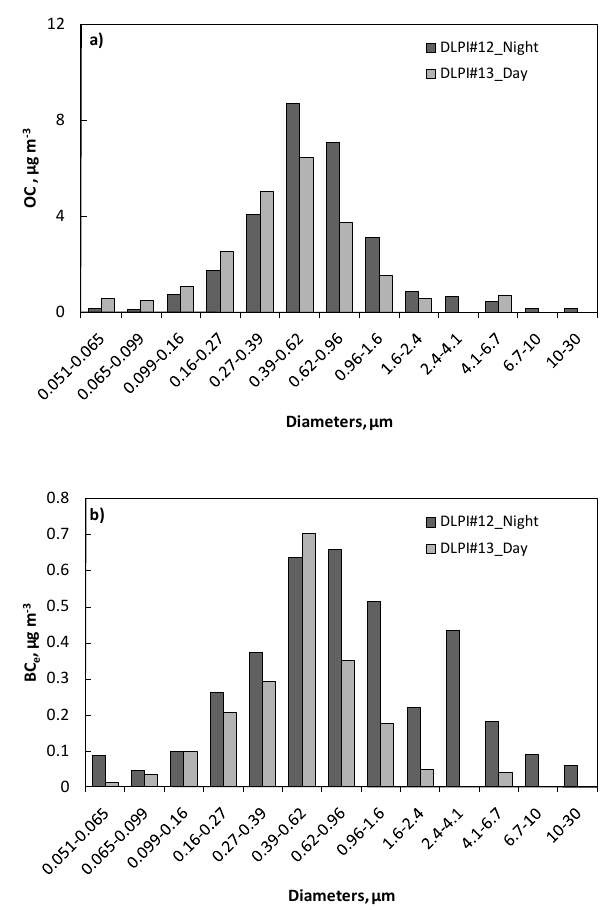
Fig. 9. Size-resolved nighttime (DLPI# 12) and daytime (DLPI# 13) (a) OC and (b) BC e concentrations for selected sam- ples. These examples show the diurnal variation of the size-resolved OC and BC e during